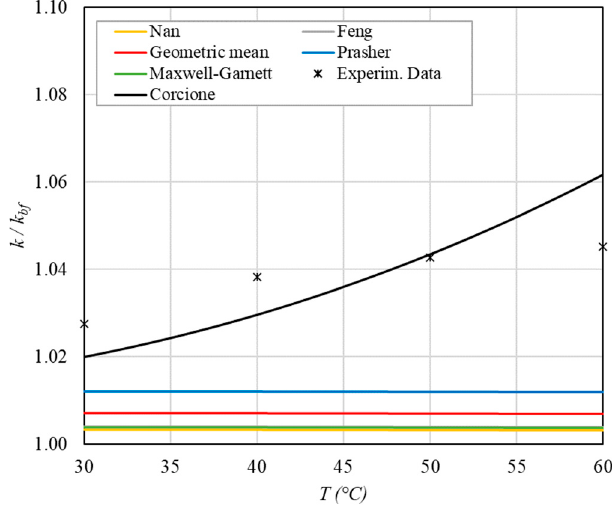
Figure 7. Increase in thermal conductivity versus temperature for φ = 0.13% .